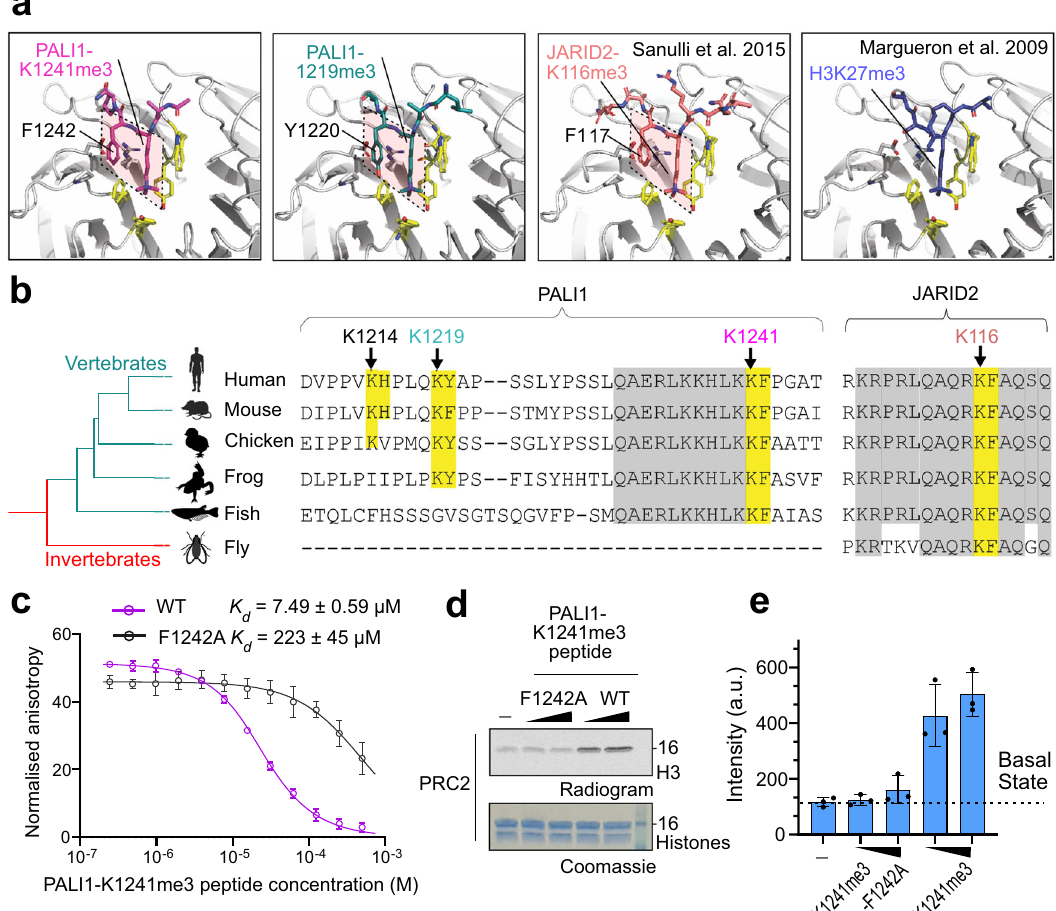
Fig. 4 Structural basis for a convergent evolution between PALI1 to JARID2. a High-resolution crystal structures of EED in a complex with either PALI1- K1241me3 (PDB 6V3X; this study), PALI1-K1219me3 (PDB 6V3Y; this study), JARDI2-K116me3 (PDB 4X3E; Sanulli et al 2015) and EED-H3K27me3 (PDB 3IIW; Margueron et al. 2009), as indicated. The methylated lysines and their + 1 adjacent conserved aromatic residues are labelled and marked in quadrilaterals. The side chains of the -1 adjacent residues to the tri-methyl-lysines — K1240 in PALI1-K1241me3 and Q1218 in PALI1-K1219me3 — could not be traced and are likely disordered. The tri-methyl-lysine peptides are in sticks representation in assorted colours and EED is in grey cartoon representation, with the exception of yellow sticks that represent the aromatic cage amino acids of EED and grey sticks that represent amino acids of EED at the vicinity of the + 1 conserved aromatic residue of the peptides. See Supplementary Fig. 4a for the omit electron densities of PALI1-K1241me3 and PALI1-K1219me3 peptides and Supplementary Fig. 3d, e for the sequence alignments and phylogenetic analysis. b Multiple sequence alignments was carried out using T-coffee 55 on entire protein sequences with the relevant regions presented (the following species were used: Homo sapiens, Mus musculus, Gallus gallus, Xenopus laevis, Oryzias latipes and Drosophila melanogaster. Phylogenetic tree was constructed based on NCBI taxonomy and visualised using iTOL 64 . The methylated lysines of JARID2 and PALI1 are labelled with arrows coloured using the same colour code as in panel c , with both the lysines and their adjacent aromatic residues are highlighted in yellow. Other vertebrate-conserved amino acids that are highlighted in grey. c Fluorescence anisotropy displacement titrations were carried out to quantify the af fi nity of EED to a PALI1-K1241me3 peptide in the presence or absence of the F1242A mutation. Each data points in the plot indicate the mean of the normalised anisotropy values and the error bars represent standard deviation over three independent replicates that were carried out on different days. Dissociation constants ( K d ) and 95% con fi dence bounds on the coef fi cient are indicated. d HMTase assay performed using PRC2 in the presence or absence of PALI1-K1241me3 peptides with or without the F1242A mutation, as indicated. The numbers on the right side of the gel and radiogram represent the molecular weight marker in kDa. e The bar plot represents the means of quanti fi cation from d using densitometry done on three independent replicates. Error bars represent standard deviation and the observed values indicated in dots. Intensity values are in arbitrary units (a.u.). Uncropped gel images used to generate this fi gure are in Supplementary Fig. 4. Source data for c – e are provided as a Source Data fi the same conformation when binding to EED (Fig. 4a, marked in EED-H3K27me3 and EED-JARID2-K116me3 complexes. The dashed shapes). Contrarily, H3K27me3, does not have an aromatic structures indicate that the two tri-methyl-lysine PALI1 peptides residue at position + 1, with respect to the tri-methyl-lysine, thus (Fig. 4a, left two panels, and Supplementary Fig. 4a) bind to EED in a adopts a different binding mode to EED (Fig. 4a, right). The essential conformation resembling that seen for the JARID2-K116me3 peptide role of the phenylalanine at the + 1 position has been previously (Fig. 4a, the third panel). Speci fi cally, in all three cases the tri-methyl- demonstrated in the case of JARID2 21 . Accordingly, a F1242A mutation in the PALI1-K1241me3 peptide prevents it from binding lysine and its adjacent aromatic residue, in the + 1 position, adopting